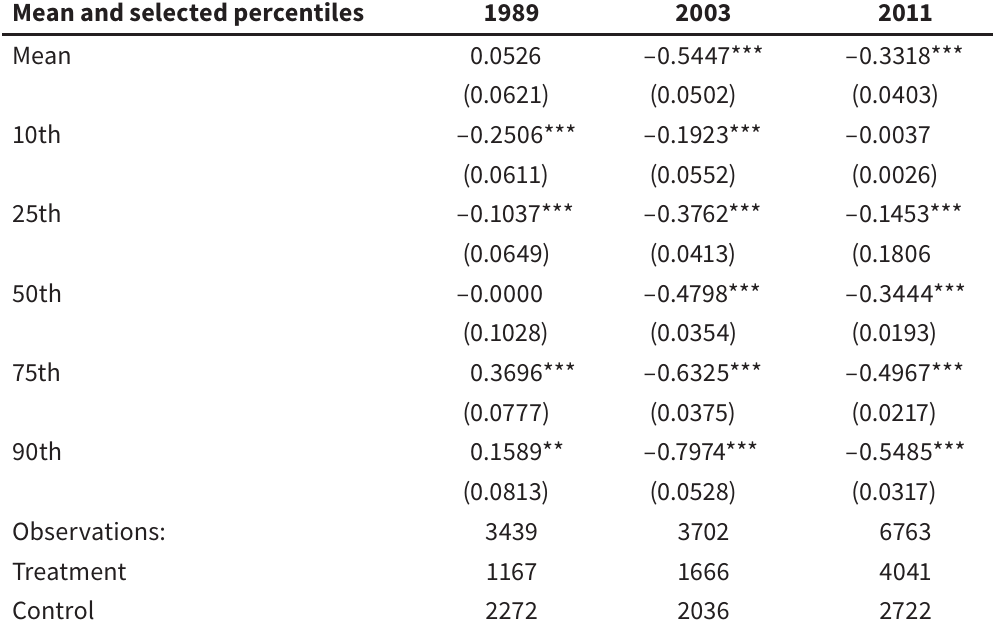
Log Household Expenditure Differentials between Conflict and Non-conflict Zones at the Mean and Selected Quantiles Mean and selected